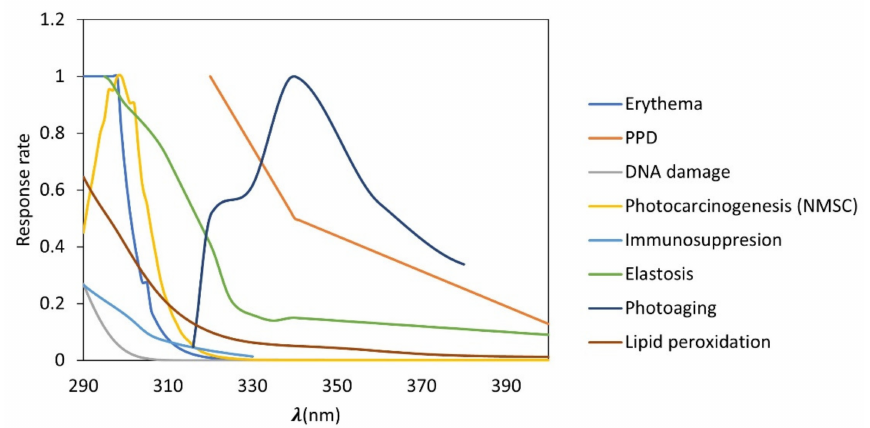
Figure 1. Biological action spectra related to different effects of ultraviolet (UV) radiation. UVB: ery- thema, DNA damage, photocarcinogenesis (NMSC; non-melanoma skin cancer), immunosuppression, UVA: persistent pigment darkening (PPD), elastosis, photoaging, and lipid